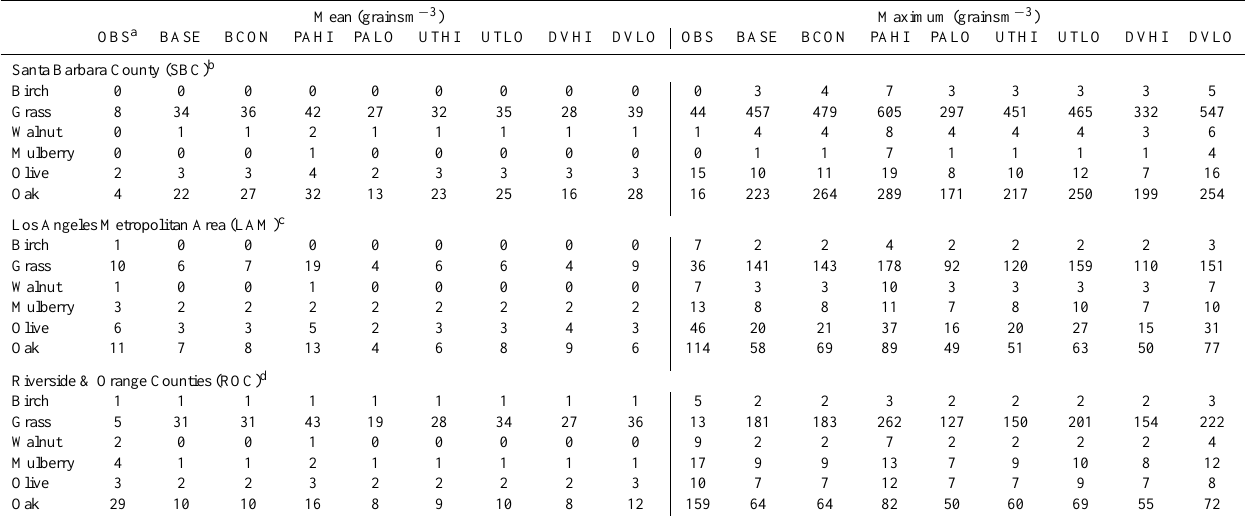
Table 4. Evaluation of simulated daily mean and daily maximum pollen concentrations (grainsm − 3 ) for different cases over three grouped regions in southern